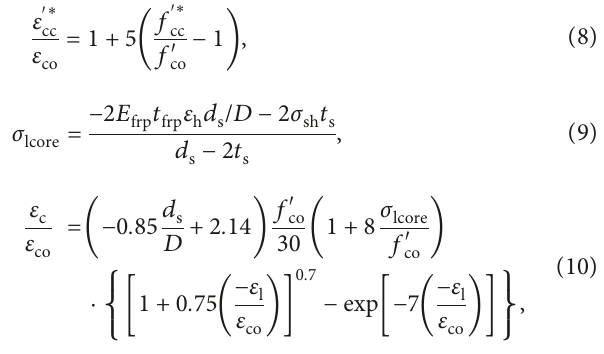
� 4mm; Type A steel tube). (b) A4-F60-M1 ( θ � ± 60 ° ; frp � 4 mm; Type A steel frp